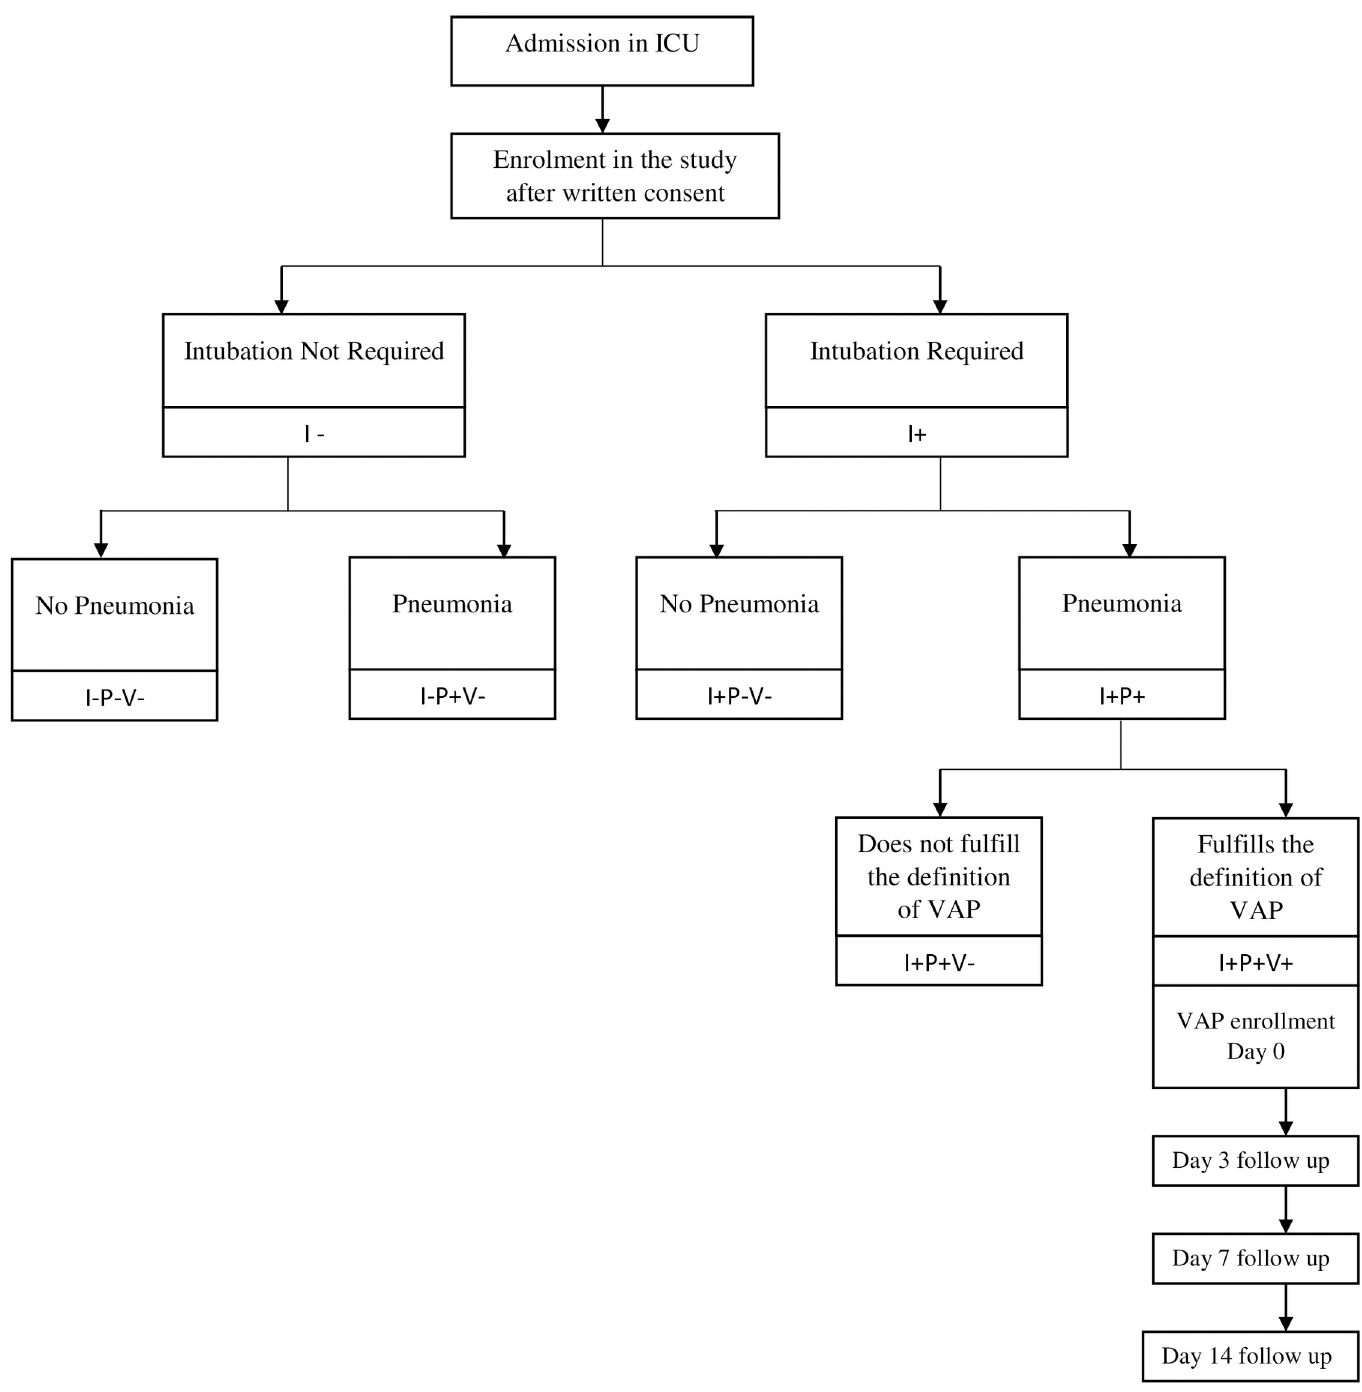
Fig 2. Flow diagram of the study enrollment procedure and categorization into five categories. Patients enrolled in the study were into five groups depending upon intubation, pneumonia development, and VAP development: These were: I-P-V- (not intubated, no pneumonia), I-P+V- (not intubated, but pneumonia developed), I +P-V- (intubated but no pneumonia), I+P+V-(intubated and pneumonia developed, but VAP not confirmed), and I+P+V+(VAP confirmed). The flow diagram of the study enrollment procedure and categorization into five categories is shown in “Fig 2”.